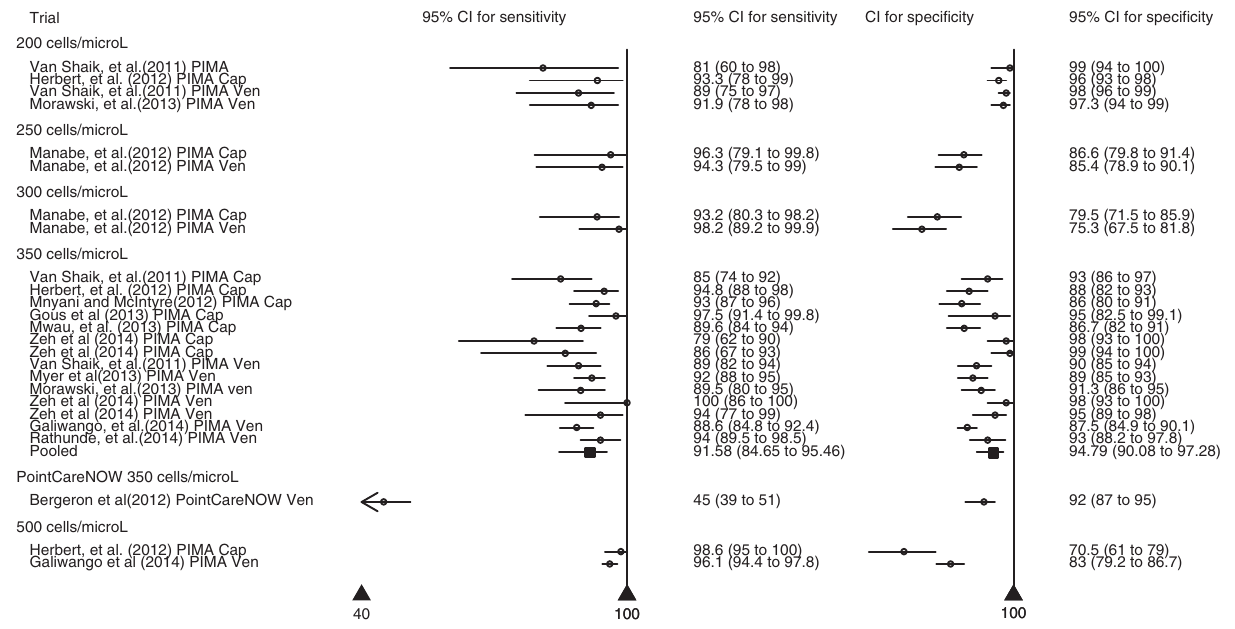
Figure 4. Accuracy results. Forest plot and pooled results, grouped by substrate used and POC